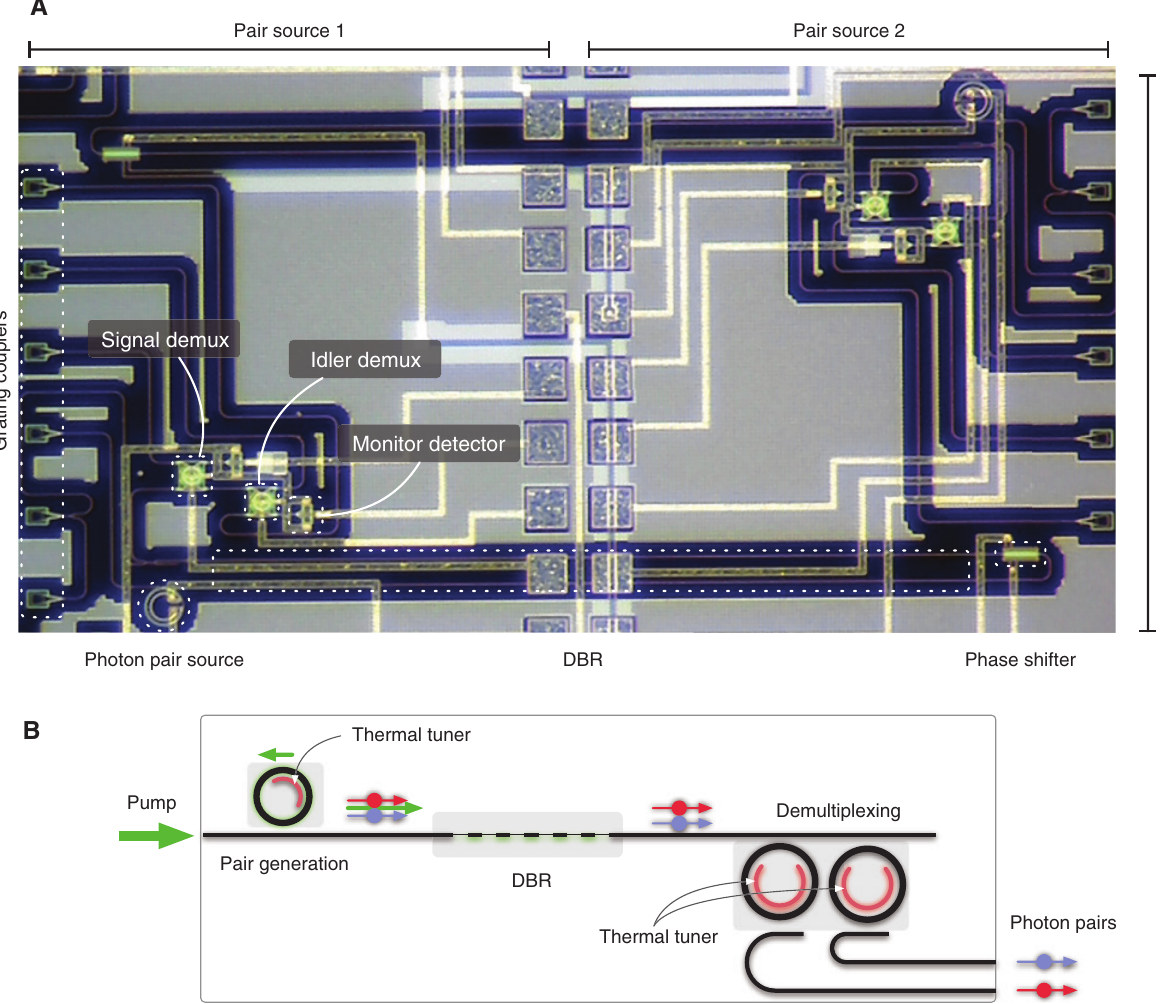
Figure 6: Optical micrograph of integrated photon-pair sources fabricated in a silicon photonics platform. (A) Optical micrograph of chip containing two photon-pair sources. (B) Schematic representation of the system depicted in the micrograph in (A). A pump field excites a microring resonator, generating pairs of quantum-correlated photons. The generated pairs and pump field pass through a distributed Bragg reflector (DBR), where the pump field is suppressed. Finally, the signal and idler photons are spatially demultiplexed using two microring resonators resonant with the signal and idler wavelengths λ and λ , s i